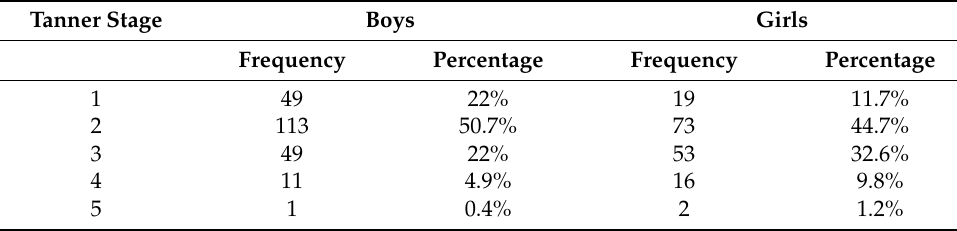
Table 2. Summary of Developmental Progression by Self-Perceived Tanner Stages.